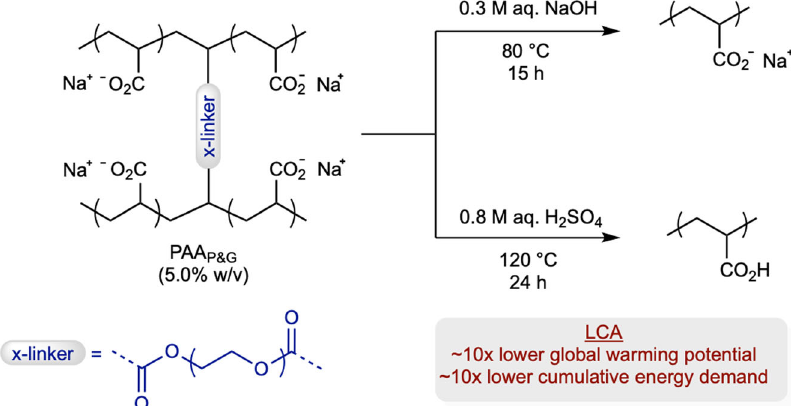
Fig. 2 Decrosslinking via hydrolysis. Reaction conditions for base-mediated and acid-catalyzed decrosslinking reactions with LCA